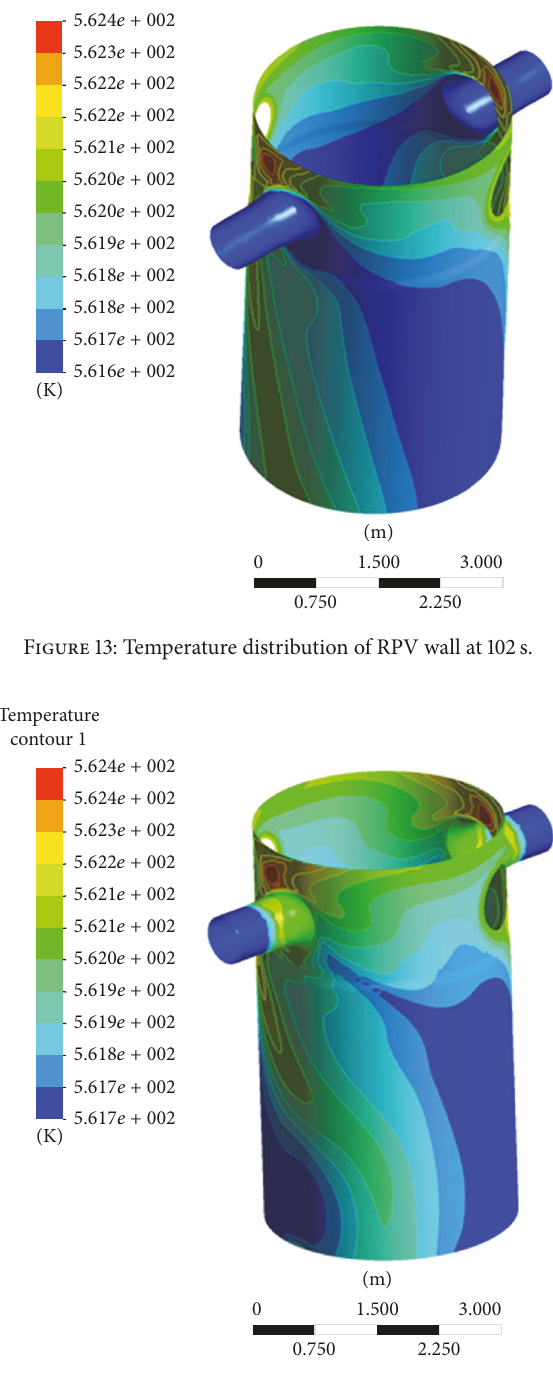
Figure 14: Temperature distribution of RPV wall at 103